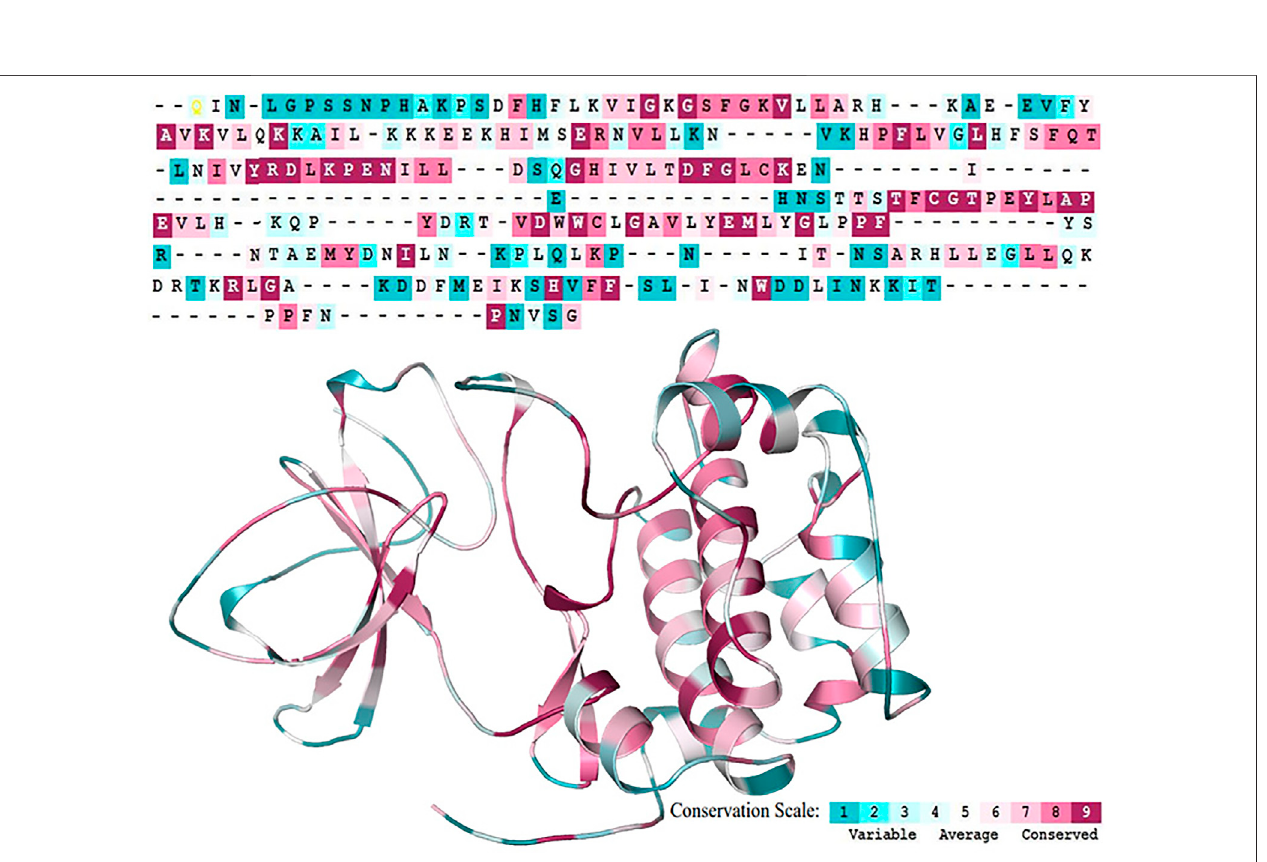
Frontiers in Molecular Biosciences |